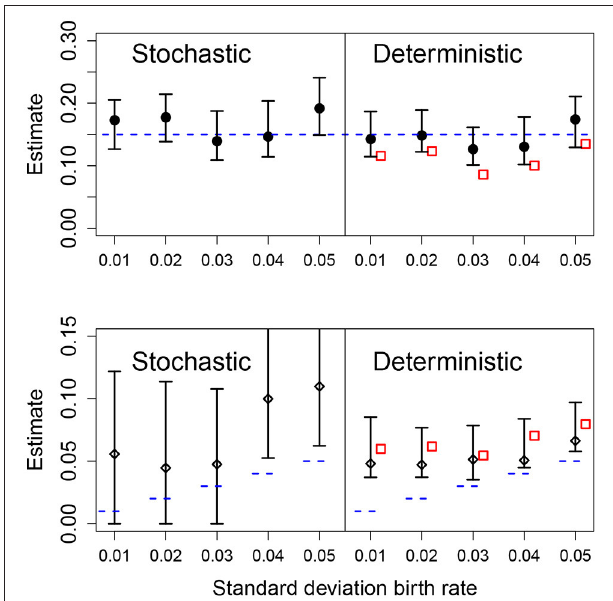
FIGURE 6 | Results of fits with increasing standard deviation for the growth rate. The data in all cases was generated by a pure birth process with parametric variability. The top row shows the estimates for the mean growth rate with stochastic or deterministic fits, and the bottom row the estimate of the standard deviation of the growth rate. The horizontal dashed blue lines indicate the parameter values used in the data generation. The vertical whiskers are the 95% CI obtained in the fits. In the right panels, the red empty squares are the estimated values obtained from standard linear mixed-effect models (regression). In each case, the number of observations per unit was O = 20 and the numbers of units was U = 20.